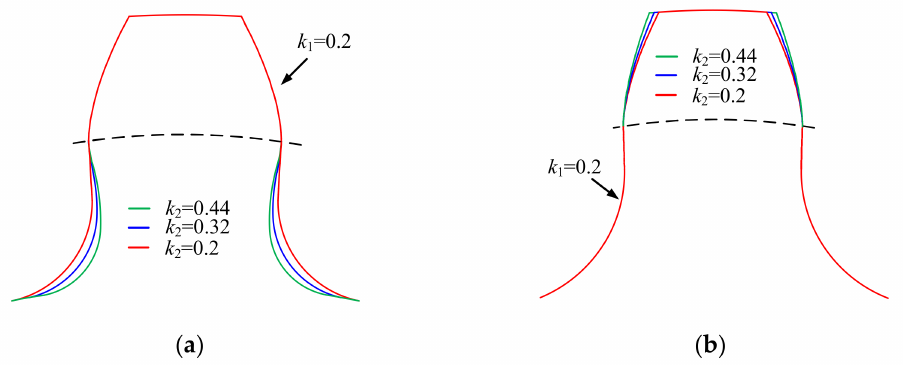
Figure 11. Effect of parabolic coefficient k 2 on the tooth profile of the novel gears. ( a ) Tooth profile of the pinion; ( b ) Tooth profile of the gear.